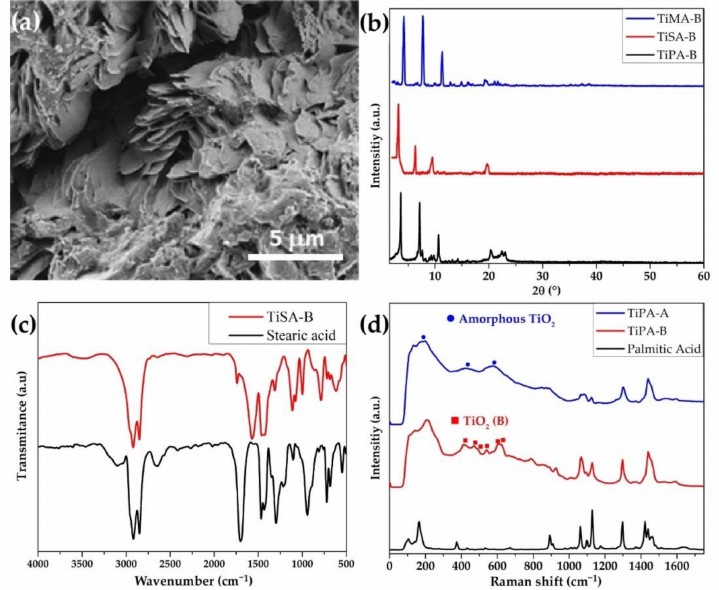
Figure 3. SEM micrograph ( a ) and XRD diffractogram TiO 2 –fatty acid ( b ); FTIR spectra of TiSA–B and stearic acid ( c ); and Raman spectra of TiO 2 –palmitic acid nanocomposites, prepared by sequential (TiPA–A) and concurrent (TiPA–B) methods, and free palmitic acid ( d